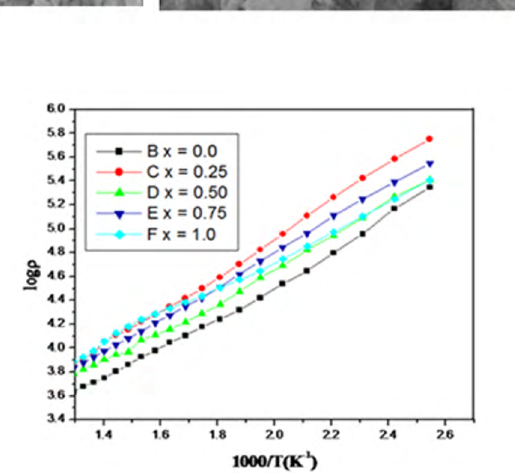
particles with an average particle size of 25 nm, which was